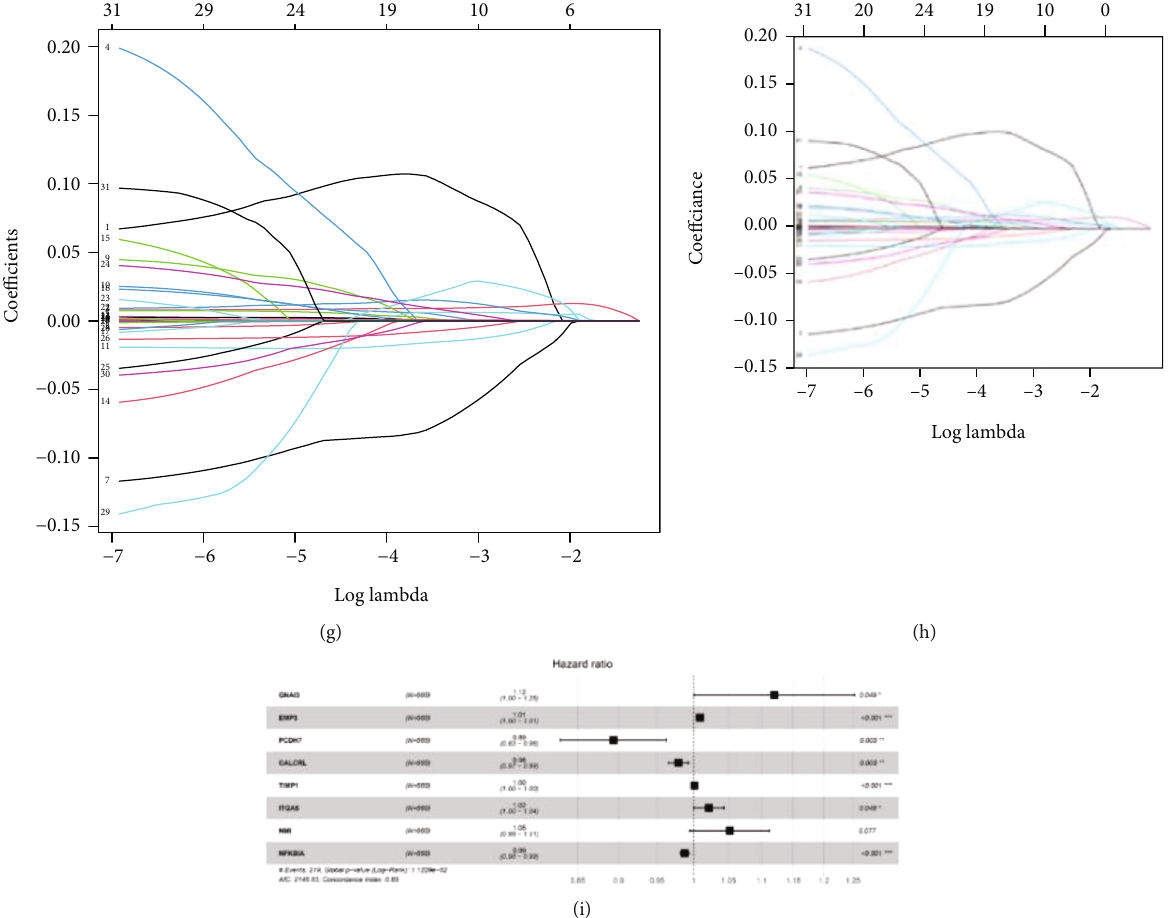
Figure 1: Identi fi cation of target genes and construction of an IRRG signature. (a) Volcano plot for di ff erentially expressed genes (DEGs) between 23 normal brain tissues and 176 glioma tissues in the GSE4290 cohort. (b) Venn diagram depicting the intersection ( n = 37 ) of DEGs and in fl ammatory response-related genes (IRRGs). (c) The expression pro fi les of 37 di ff erentially expressed IRRGs (DE-IRRGs). (d) Protein-protein interaction (PPI) network showing the interactions among 37 DE-IRRGs genes. (e) The correlation network of 37 DE-IRRGs genes by Spearman analysis. (f) Univariate Cox regression analysis to determine 31 prognostic DE-IRRGs ( P < 0 : 05 ) in TCGA cohort. (g) LASSO regression analysis for further screening out the 11 candidate genes. (h) Illustration of the LASSO coe ffi cient spectrum for the 11 candidate genes. (i) Multivariate Cox regression analysis identi fi es 8 target genes. ∗ P < 0 : 05 , ∗∗ P < 0 : 01 , and ∗∗∗ P < 0 : 001